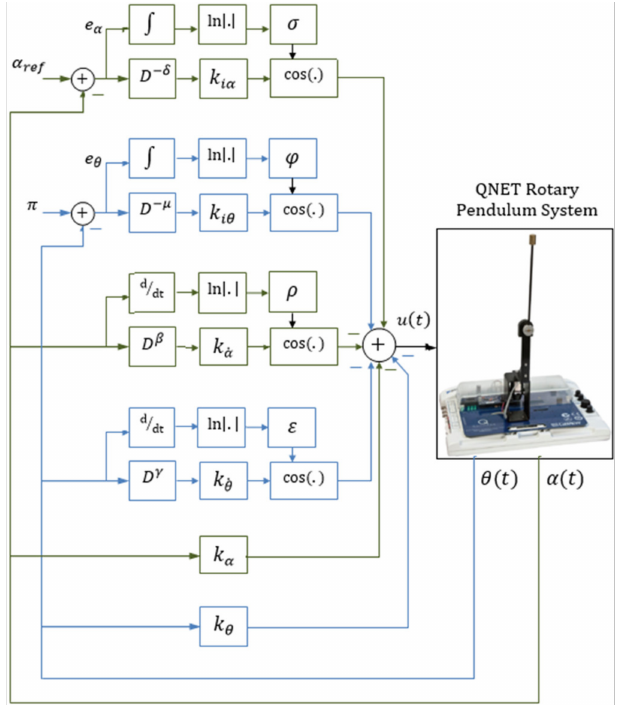
Figure 2. Block diagram of the proposed CFO-LQIR